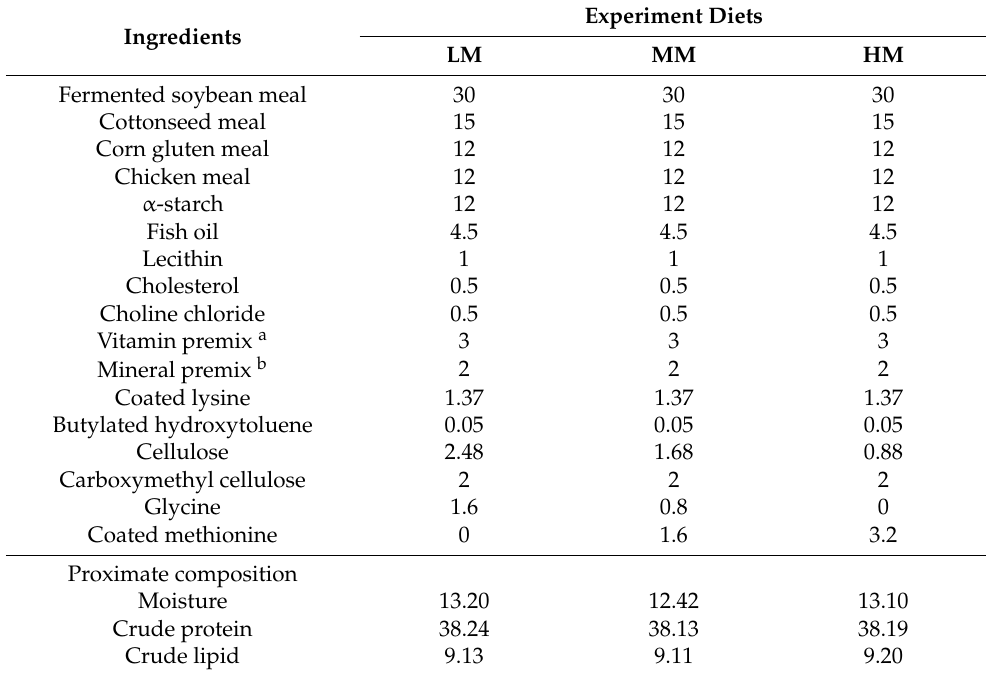
Table 1. Formulation and chemical proximate composition of experimental diets (dry matter basis, %).